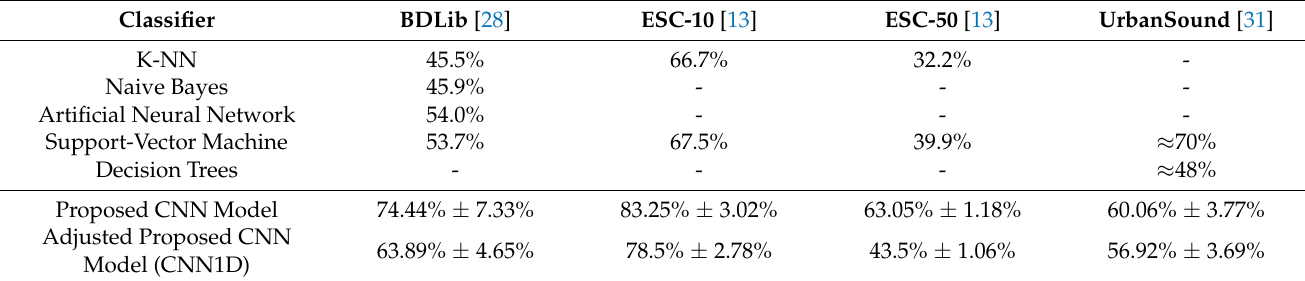
Table 3. Classifiers’ accuracy and standard deviation per dataset reported in the literature [6] compared to the proposed CNN model.